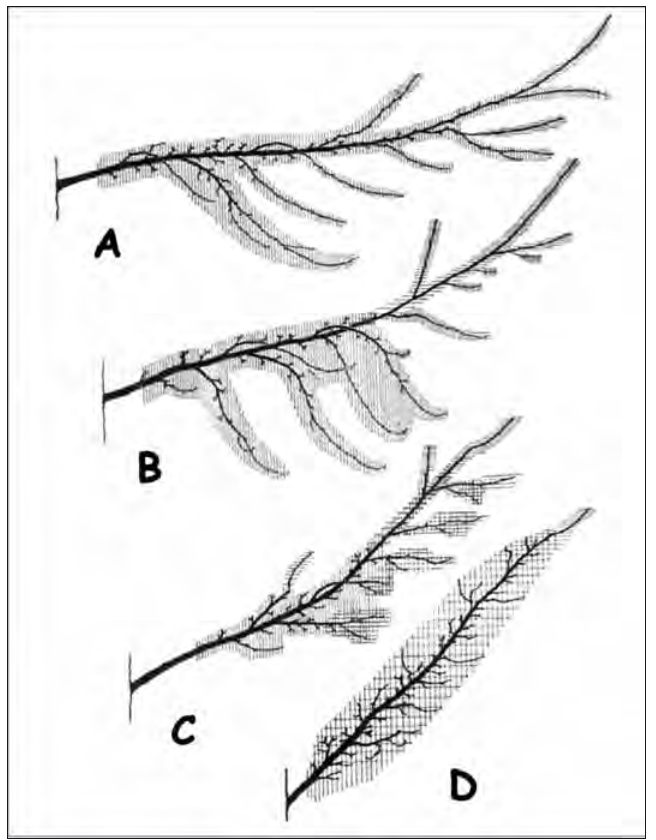
Fig. 9 - Formation of lateral axes of different types and ages on an apple tree branch pruned according to the various pruning crite- ria used in four training systems, which diverge from the natu - ral behaviour very little (A) to very much (D) (redrawn from Hilkenbäumer,